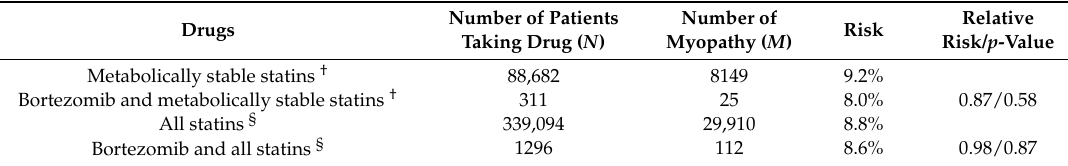
Table 2. DDI-myopathy